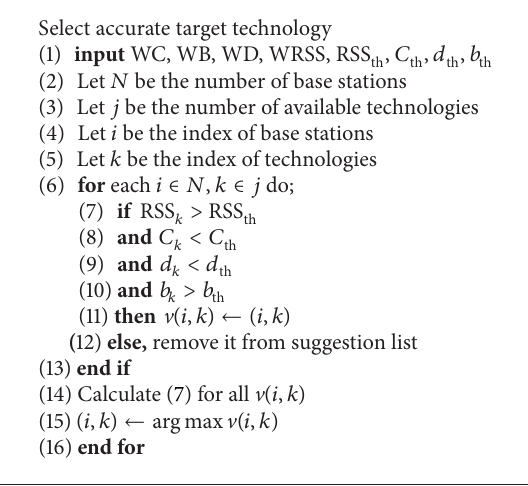
Algorithm 1: Evaluation of the BS’